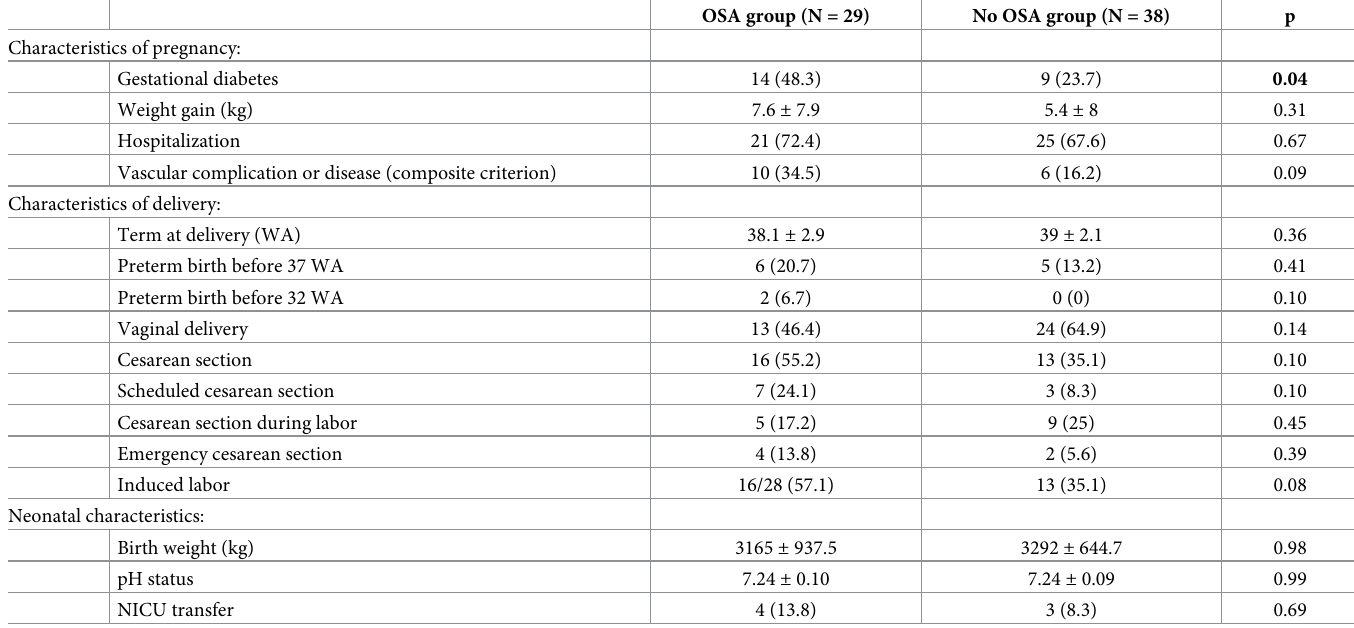
Table 2. Characteristics of pregnancy, delivery and new born according to the OSA or no OSA